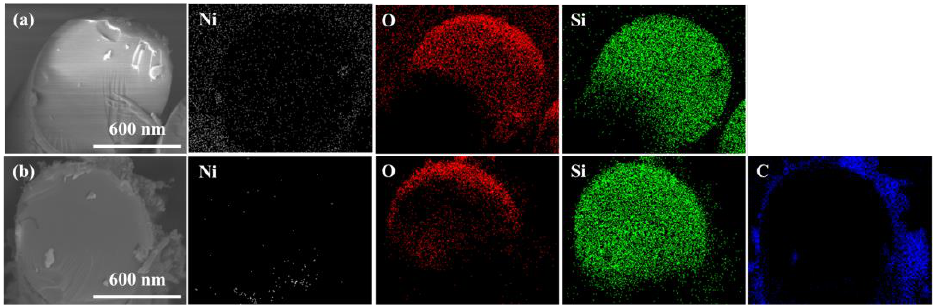
Figure 3. SEM – EDS mapping images showing the distribution of carbon, nitrogen, oxygen, silicon, and nickel in the cross-section of the glass fiber: ( a ) HNGF-120 and ( b ) HNGF-CNTs-120.